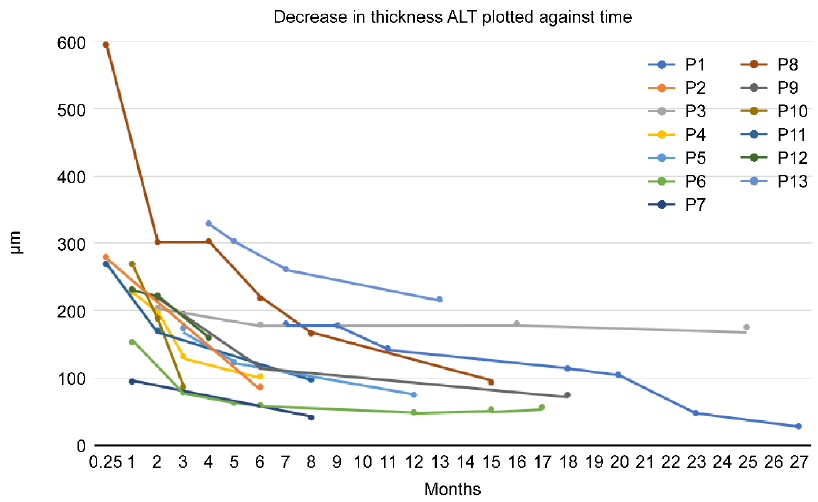
Figure 2. Decreased thickness of ALT plotted against time (P1 – 13 = numbered patients). An exemplary clinical case (P6) is shown in Figure 3.